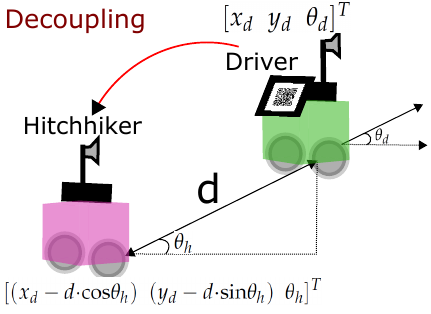
Figure 6. Decoupling